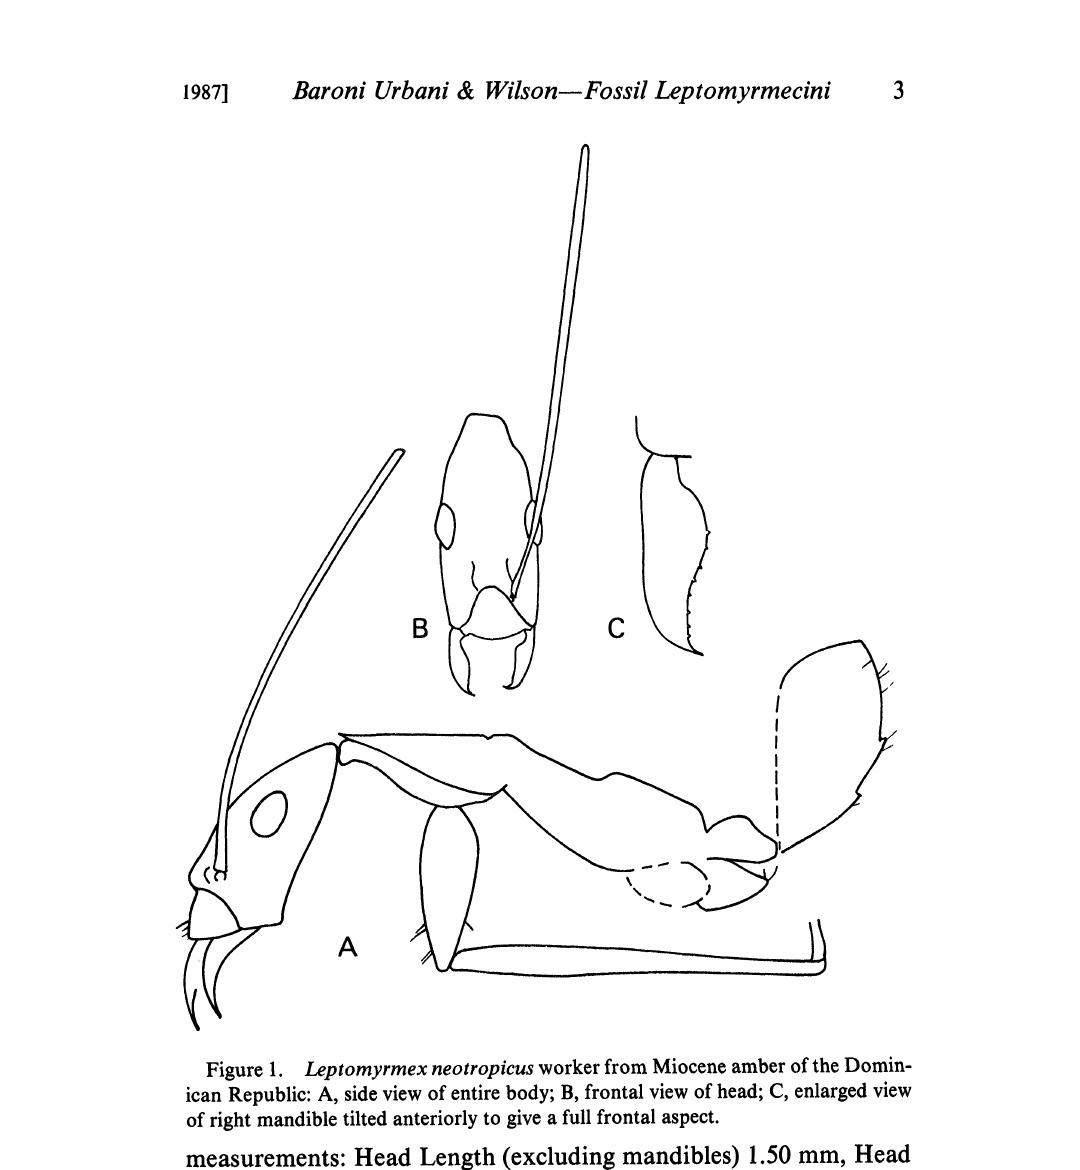
Figure 1. Leptomyrmex neotropicus worker from Miocene amber of the Domin- ican Republic: A, side view of entire body; B, frontal view of head; C, enlarged view of right mandible tilted anteriorly to give a full frontal